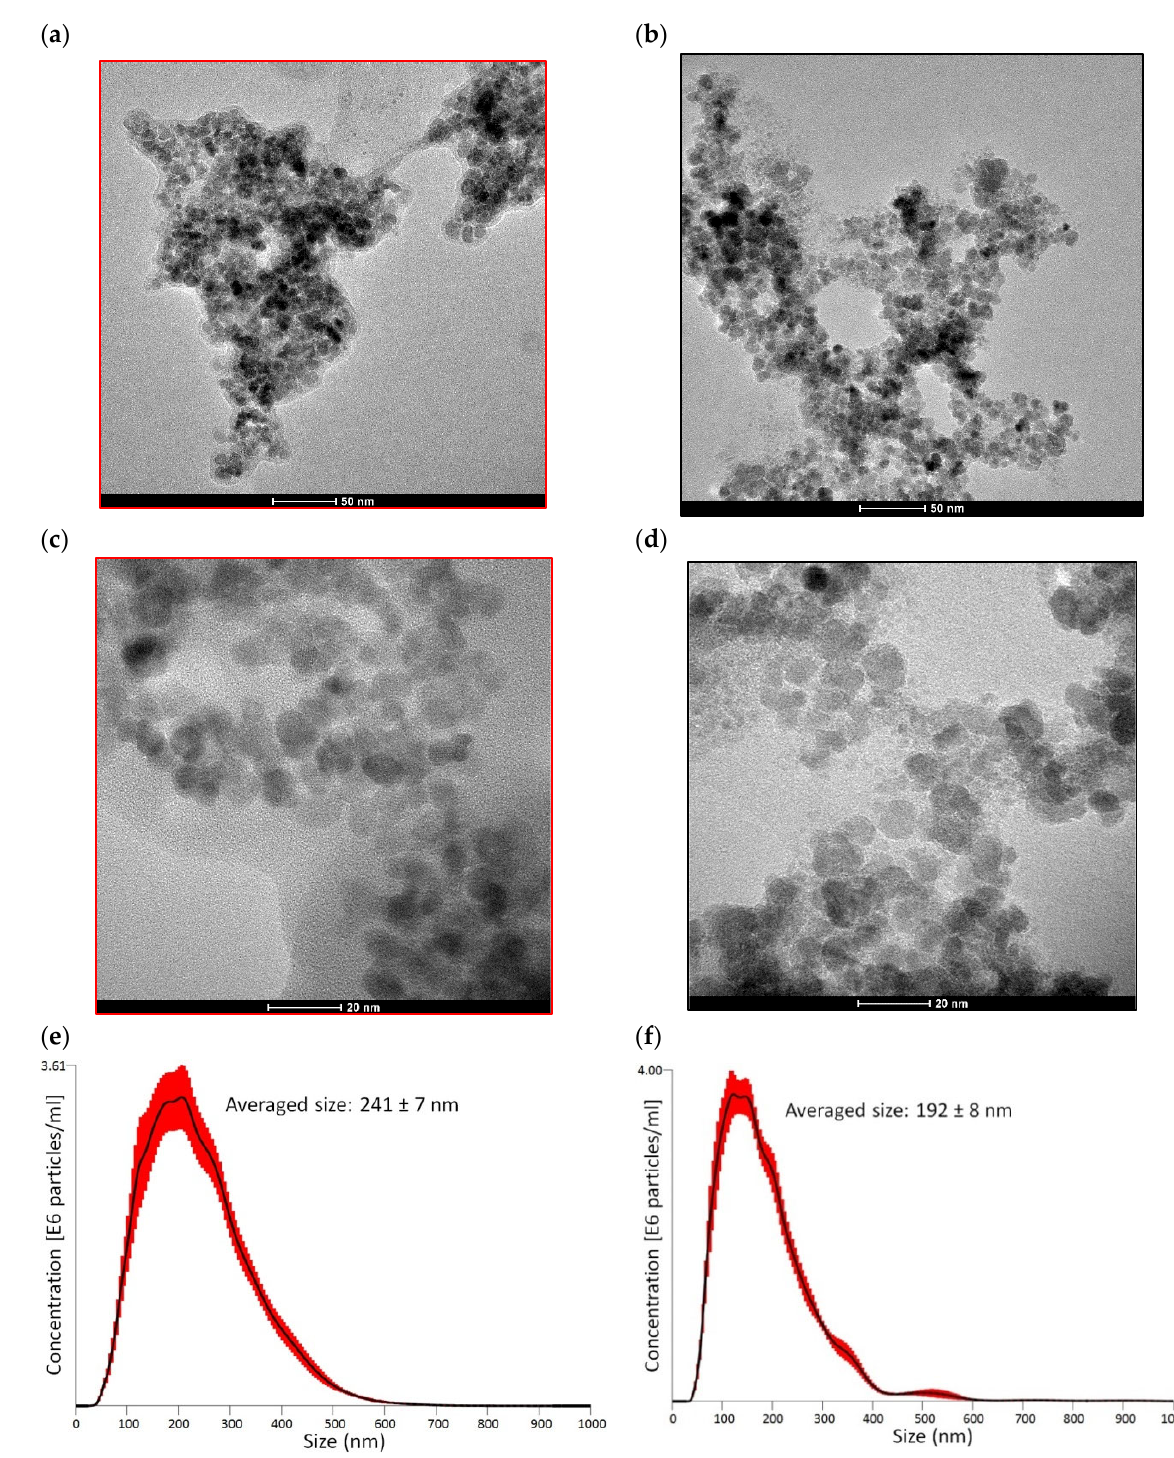
Figure 2. TEM images and particle size distributions by NTA method of Fe 3 O 4 NPs ( a , c , e ) and Fe 3 O 4 /PSA NPs ( b , d , f ).